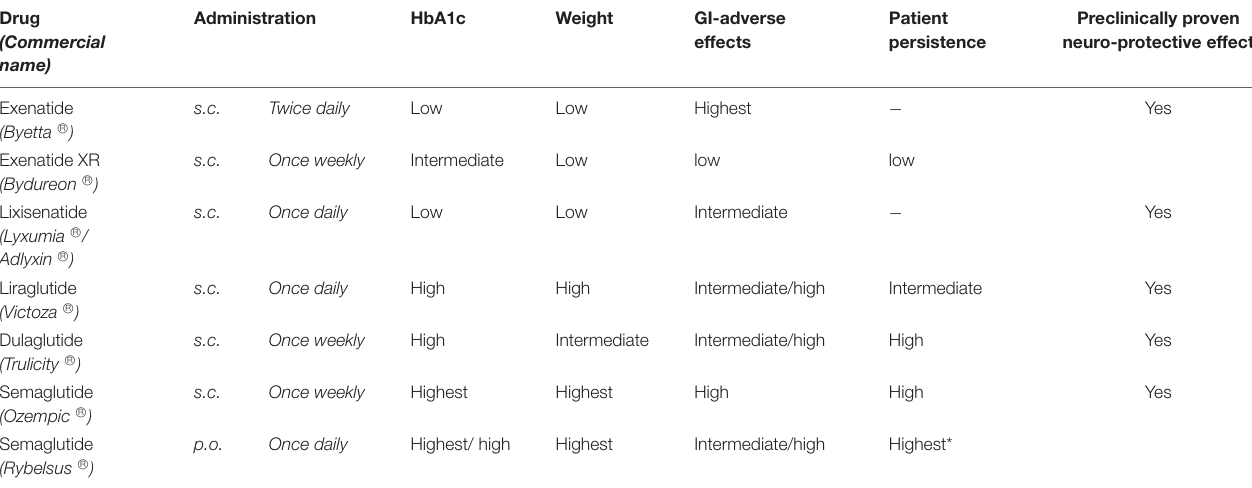
TABLE 1 | Comparison of various currently available GLP-1 receptor